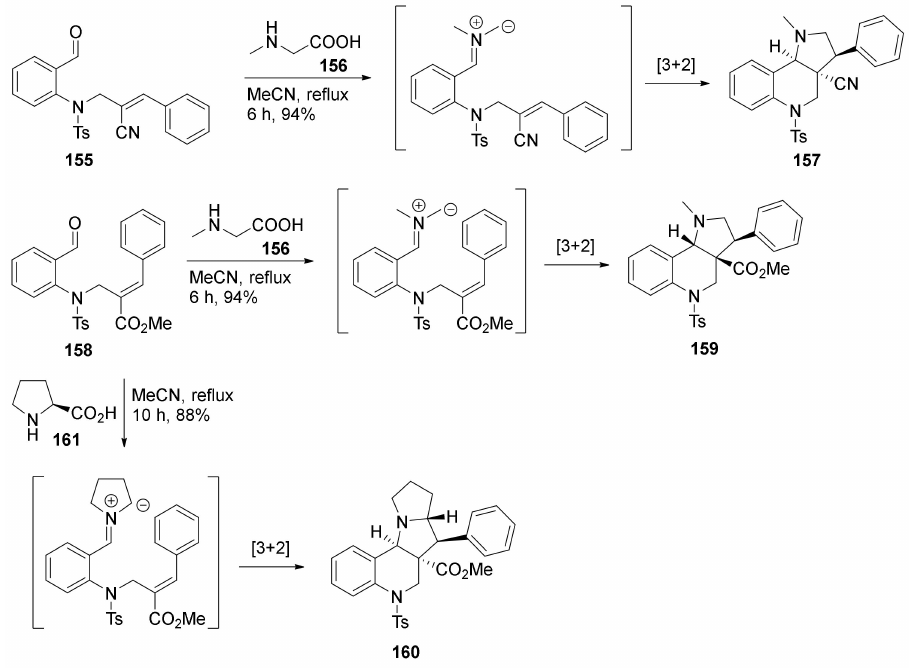
Scheme 25. Scaffold synthesis by Bakthadoss and